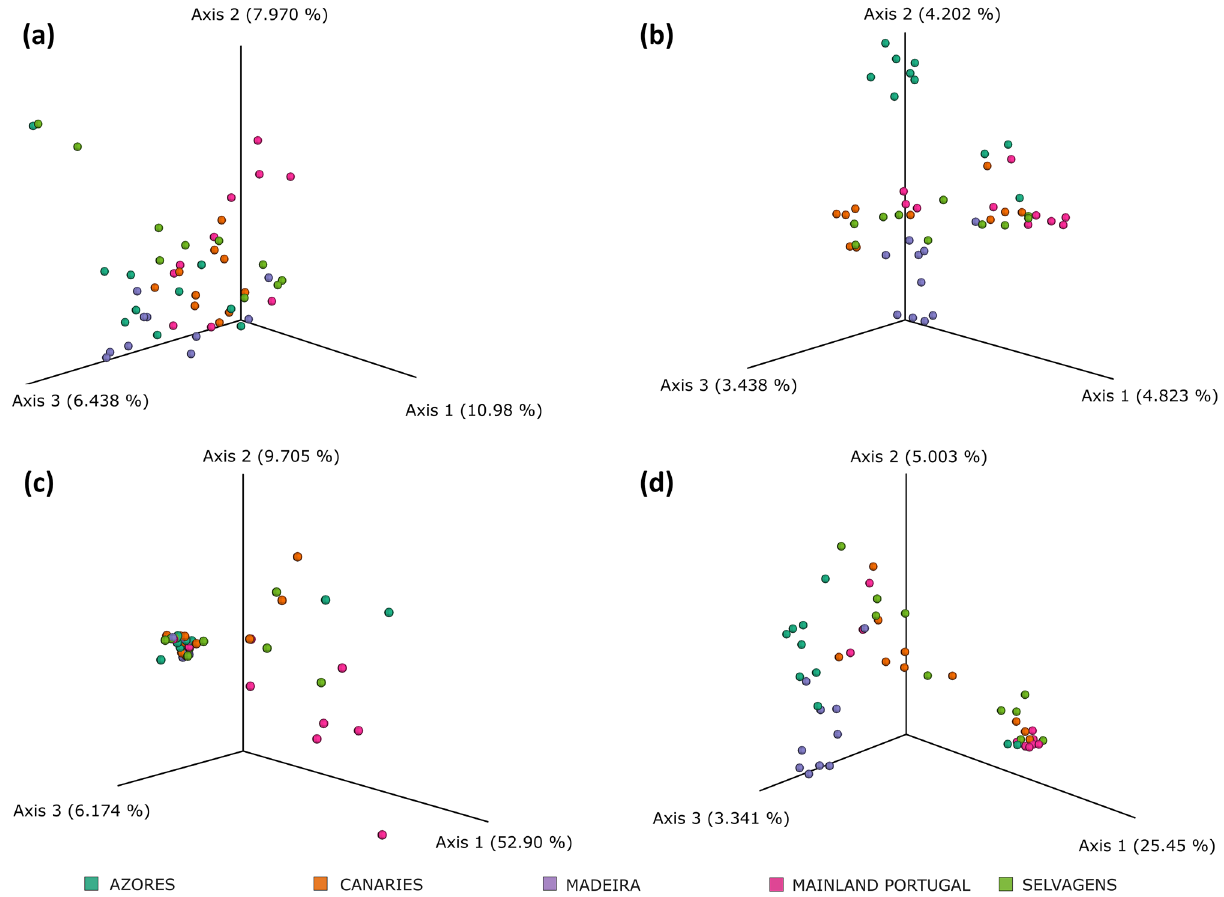
Figure 4. Principal Coordinates Analyses of the Beta diversity using the Bray Curtis ( a ), Jaccard Index ( b ), Weighted Unifrac ( c ), and Uniweighted Unifrac ( d ) for 50 samples of the microbiome of the mollusc Phorcus sauciatus from 5 intertidal locations in the Atlantic Ocean (mainland Portugal and the islands of Madeira, Selvagens, Azores and the